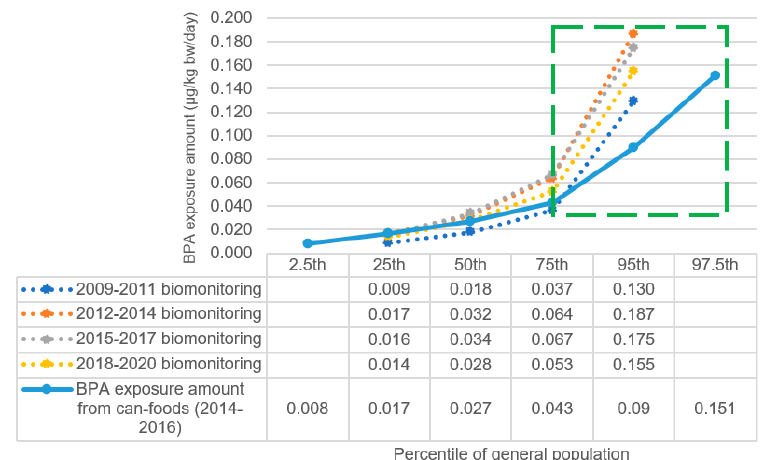
Figure 1. Compared estimated daily intake of bisphenol A (µg/kg bw/day) from canned foods and exposure based on urinary BPA concentration (µg/g creatinine) in Korean general population (Source: Korean National Environmental Health Survey (KoNEHS), 2015–2017)